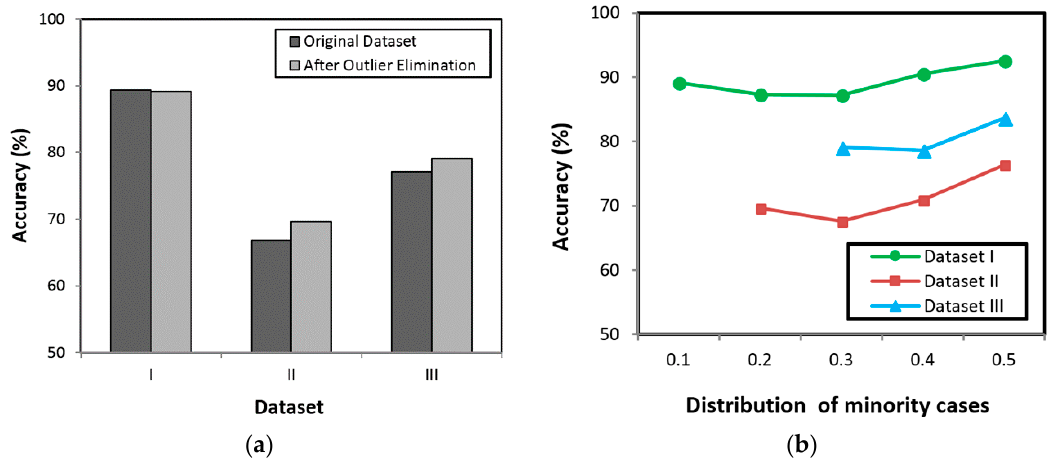
Figure 4. Impact of outlier elimination ( a ) and distribution of minority cases ( b ) on model accuracy.